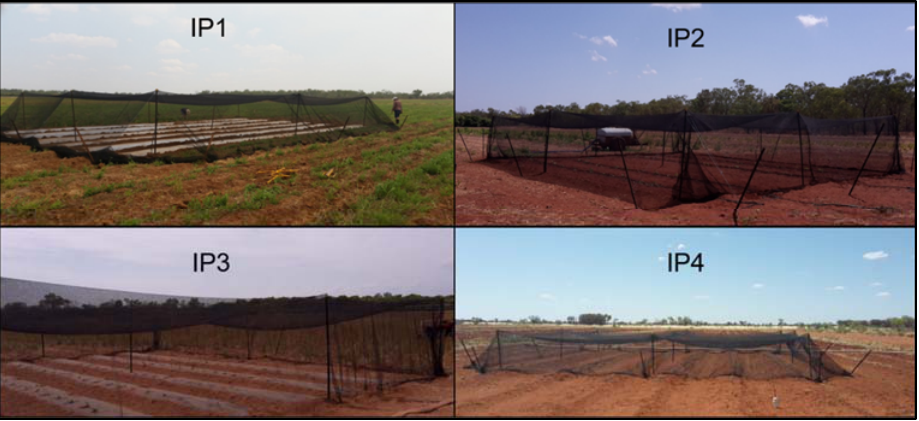
Figure 4. Completed field bed sites with insect proof netting at each of the four field site locations